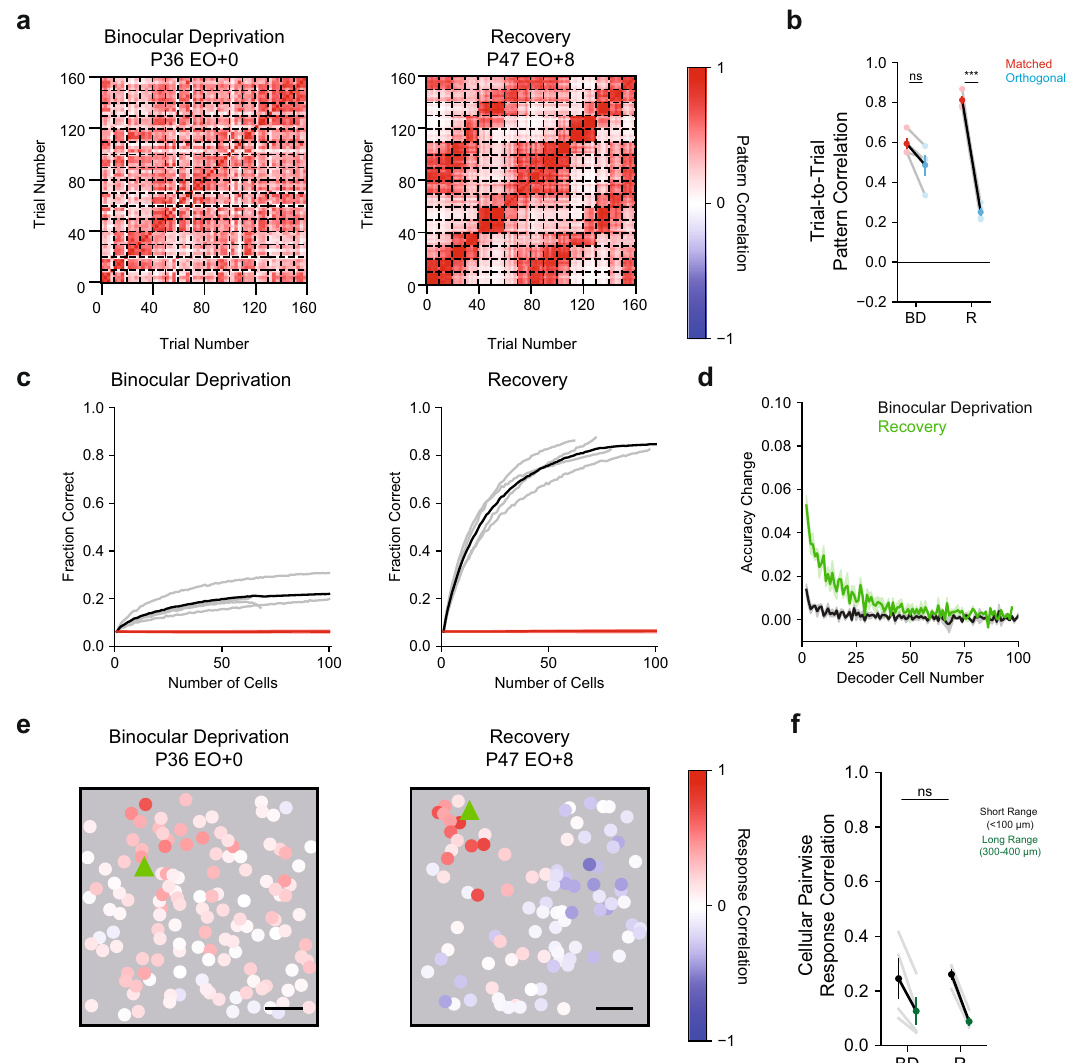
Fig. 5 Reduction in spatially uniform responses occurs without visual experience. a Trial-to-trial pattern correlations for a Binocular Deprivation (left) and Recovery (right) animal. Trials were sorted by direction, such that each group of 10 trials corresponds to the repeated presentation of a stimulus direction. Sixteen directions were presented equally spaced between 0 and 337.5 degrees. Dashed lines denote groups. b Comparison of matched (red) and orthogonal (blue) trial-to-trial pattern correlations for Binocular Deprivation ( p = 0.0718, n = 4) and Recovery ( p = 0.0003, n = 4) animals. Individual animals are shown as gray and error bars denote SEM. Two-tailed paired Student ’ s t test. c Template decoding accuracy for Binocular Deprivation ( n = 4) and Recovery ( n = 4) animals for different template sizes. Red line indicates chance decoding levels, black shows average decoding level, and gray lines denote individual animals. d Change in decoder accuracy for the nth cell included in the template decoder for Binocular Deprivation (black, n = 4) and Recovery (green, n = 4) animals. Shaded regions denote SEM. e Example cellular pairwise correlations for Binocular Deprivation (left) and Recovery (right) animals. The seed cell is denoted by the green triangle and scale bar denotes 100 μ m. f Binocular Deprivation ( n = 4) and Recovery ( n = 4) differences of cellular pairwise response correlations for short- (<100 μ m) and long-range (300 – 400 μ m) pair are similar. *** p < 0.0005, ns not signi fi cant. Source data are provided as a Source Data fi How well is the large-scale organization of GABA-INs re fl ected short- and long-range cell pairs were systematically lower for BD in the cellular response? We assessed the spatial organization of animals when compared to Naive animals (Naive short cellular response correlations (Fig. 5e, Supplementary Fig. 5d – f) 0.49 ± 0.07 vs. BD short 0.25 ± 0.08, p = 0.0392; Naive long and found that both BD and Recovery animals demonstrated 0.36 ± 0.08 vs. BD long 0.13 ± 0.05, p = 0.0448; n = 4 vs. 7, higher correlations for short-range (<100 μ m) compared to long- Mean ± SEM, bootstrap test). However, BD animals had a range (300 – 400 μ m) cell pairs (Fig. 5f, BD short 0.25 ± 0.08 vs. signi fi cantly lower correlation for neighboring GABA-INs long 0.13 ± 0.05, p = 0.0357, n = 4; Recovery short 0.26 ± 0.02 vs. compared to age-matched animals with Brief experience (BD long 0.09 ± 0.02, p = 0.0028, n = 4; Mean ± SEM, Student ’ s paired short 0.25 ± 0.08 vs. Brief short 0.43 ± 0.03, p = 0.0392; BD long t test). The difference in correlations for short- and long-range 0.13 ± 0.05 vs. Brief long 0.04 ± 0.03, p = 0.1012; n = 4 vs. 6, cell pairs were like animals with normal extended experience (BD Mean ± SEM, bootstrap test). Thus, the widespread, correlated 0.12 ± 0.03 vs. Extended 0.19 ± 0.02, p = 0.0630, n = 4 vs. 4, activity that dominates responses in Naive animals was reduced Mean ± SEM, bootstrap test). Importantly, correlations for both in BD animals, but short-range correlations were impaired. In